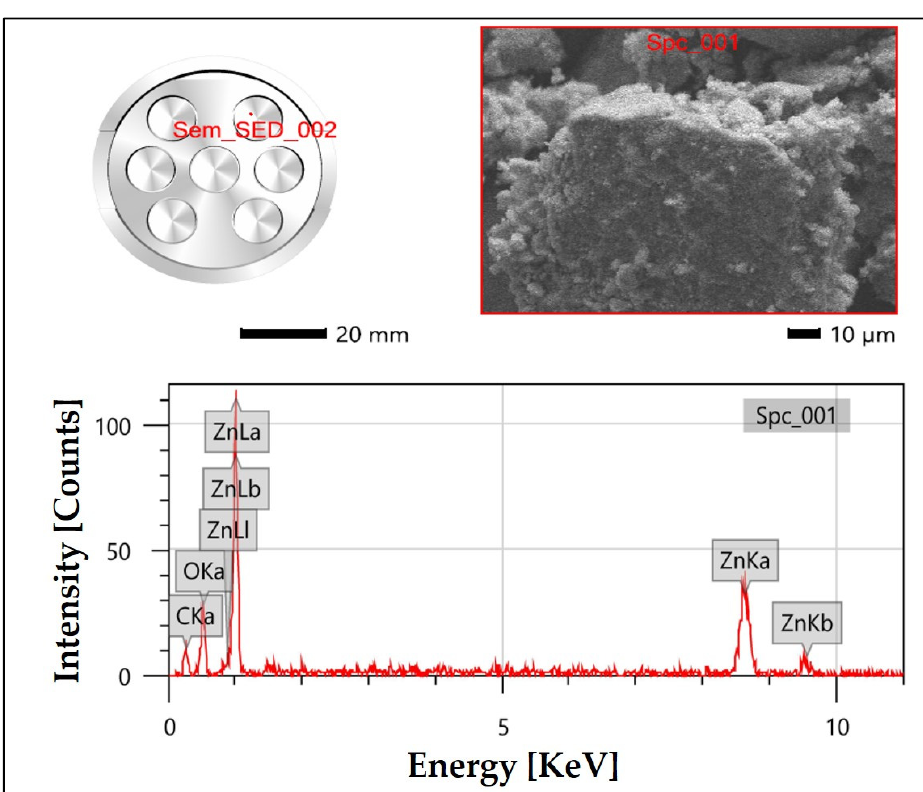
Figure 7. EDS result of ZnONPs of leaf extracts of R. sativus showing measurement conditions.